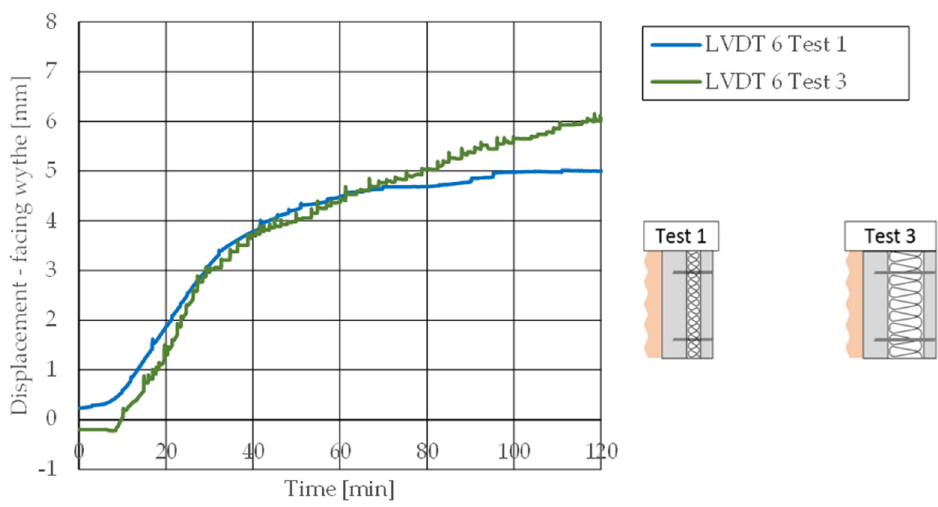
Figure 11. Relative displacement of the facing wythe.